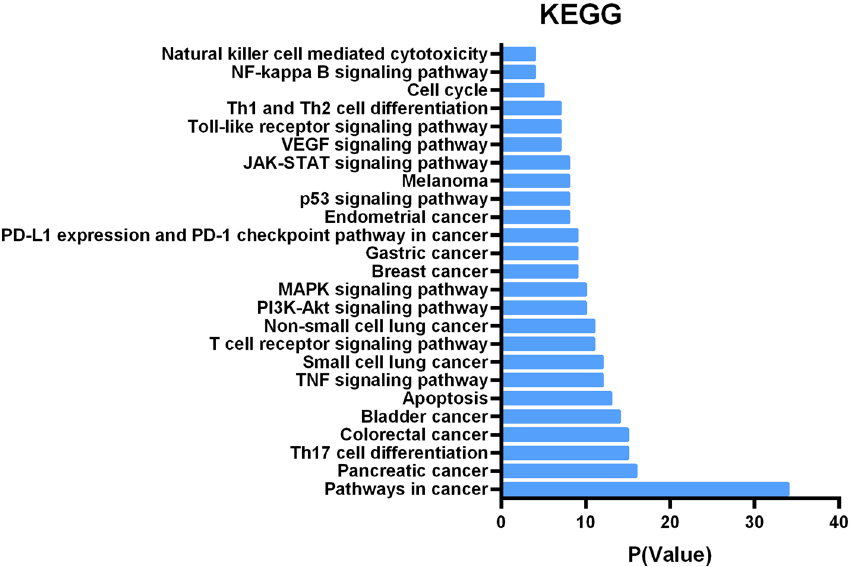
Figure 1. Kyoto Encyclopedia of Genes and Genomes (KEGG) analysis of potential targets. The Y-axis showed significantly enriched “pathway” categories in KEGG of the potential targets, and the X-axis showed the enrichment scores of these terms (P-value <